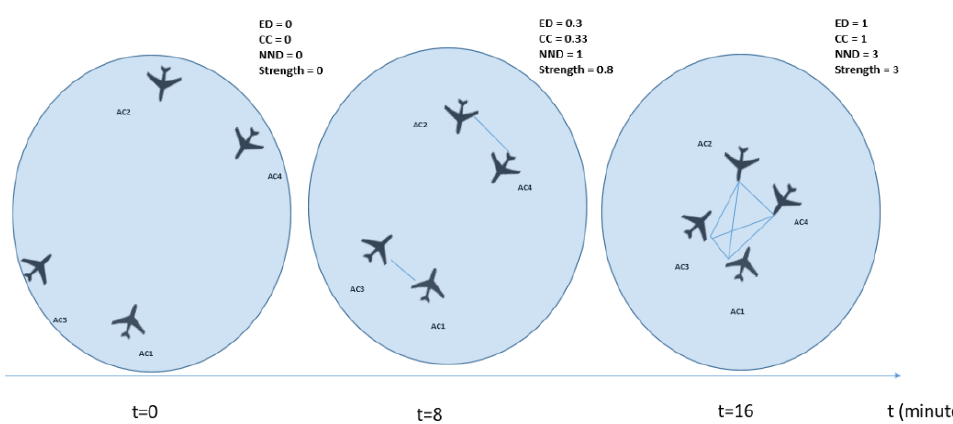
Figure 7. A more realistic example scenario.